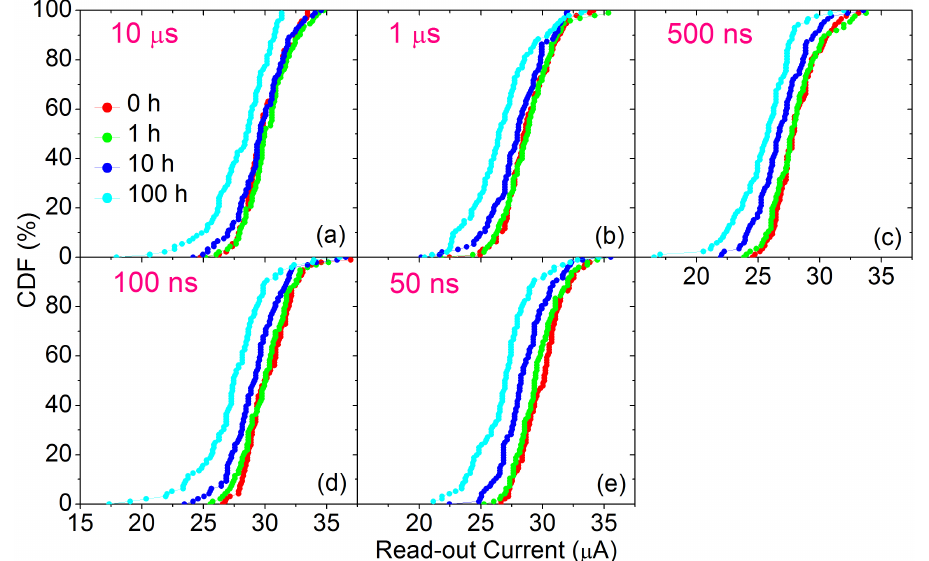
Figure 9. CDFs of read-out currents sampled after 0, 1, 10 and 100 h of annealing at 150 o C during the retention test for every programming pulse width: 10 µ s ( a ), 1 µ s ( b ), 500 ns ( c ), 100 ns ( d ) and 50 ns ( e